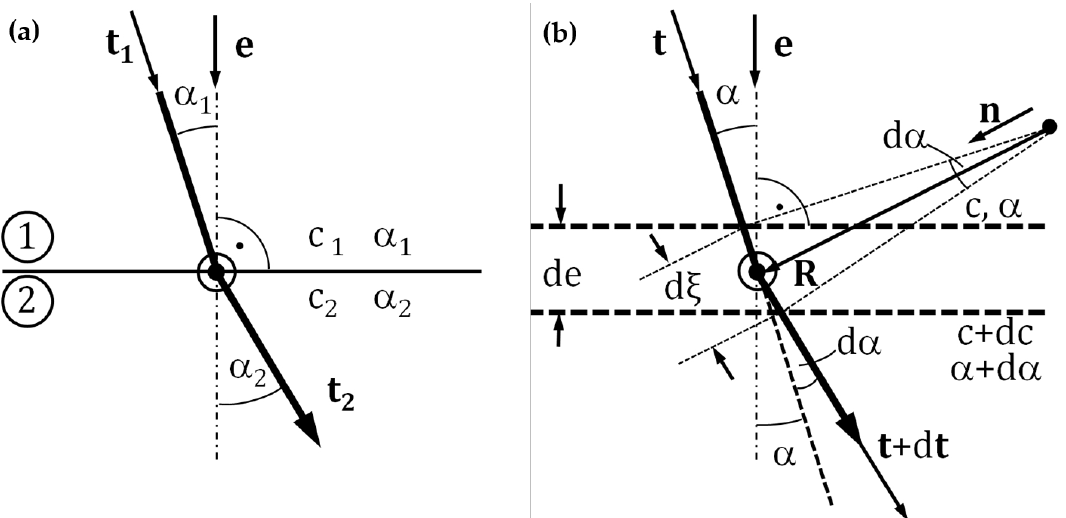
Figure 1. 1D-waveguide with sinusoidal wave propagation (single waveguide element is displayed): Two-way wave equation with two solutions according to the wave velocities + c and – c vs. One-way wave equation with one unique solution acc. to the chosen wave velocity c (here: + c ). > c and c (here: c ) is refracted from the angle α to 1 2 2 1 1